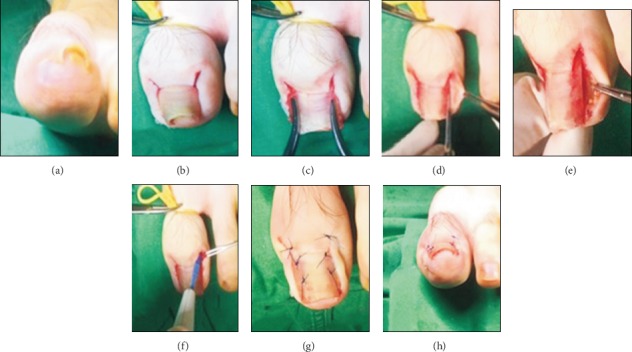
Nail plate and bed reconstruction technique [44].